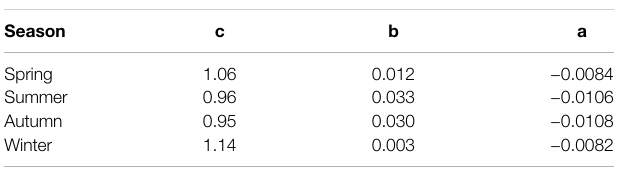
TABLE 2 | Empirical coef fi cients value of c, b, and a.